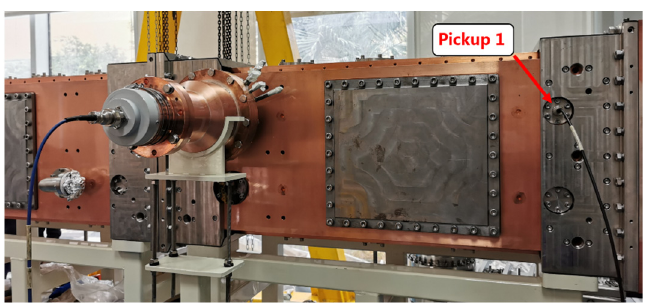
Figure 6. Coupling factor for setup.